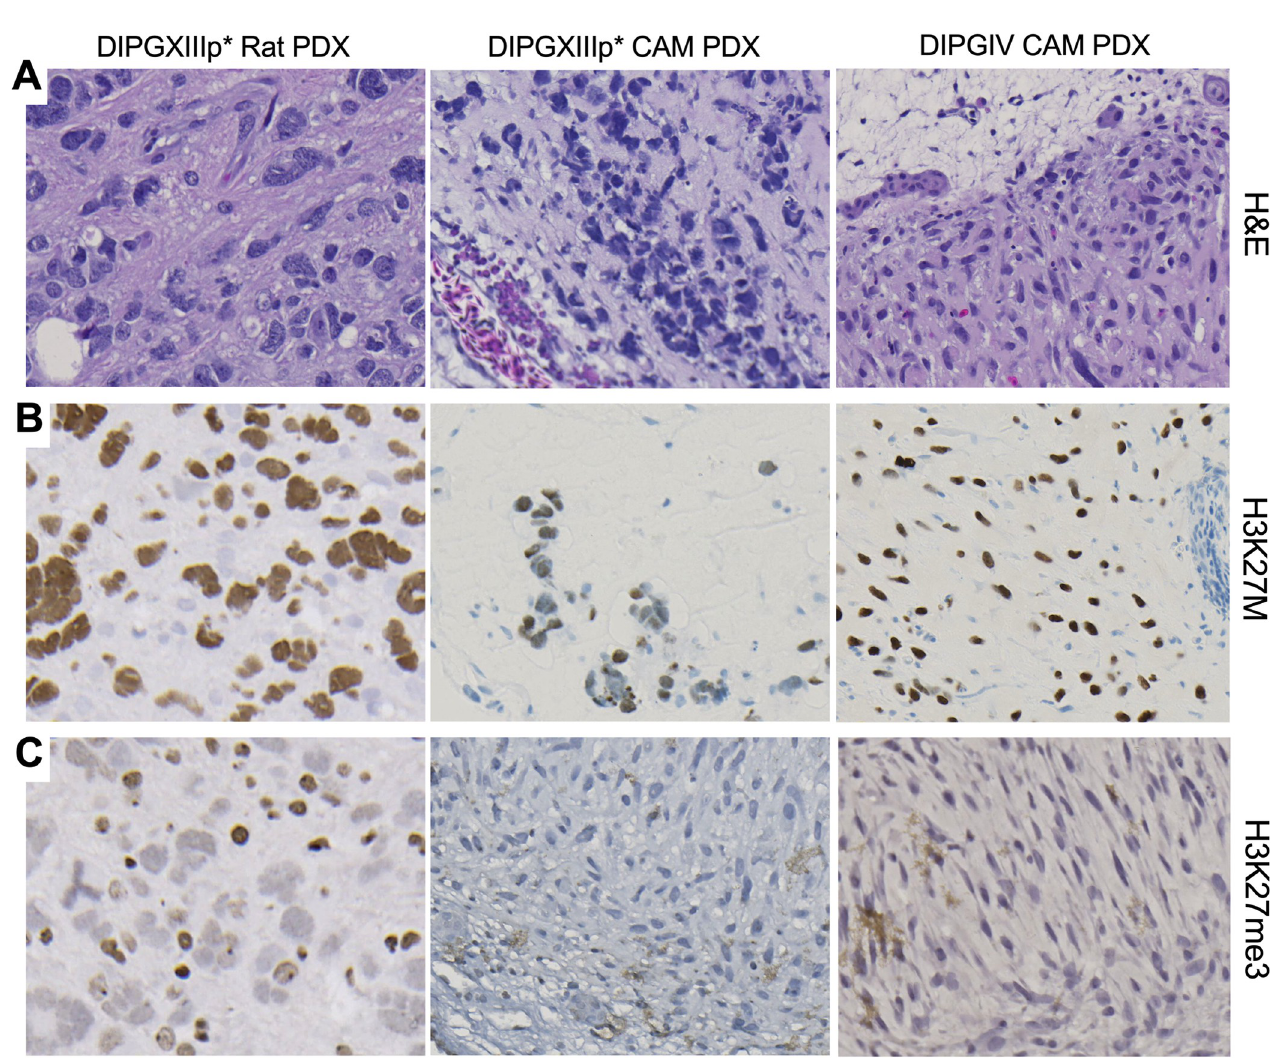
Fig 2. DIPG CAM tumors maintain molecular features of native tumor and rodent xenografts. (A) Hemoxylin and Eosin (H&E) staining of DIPGXIIIp � rodent, DIPGXIIIp � CAM and DIPGIV CAM tumors show tumor cell growth and invasion. Immunohistochemistry (IHC) staining shows positive H3K27M mutation status (B) and reduction of H3K27 trimethylation (C) for all tumors. All images were taken at 20X